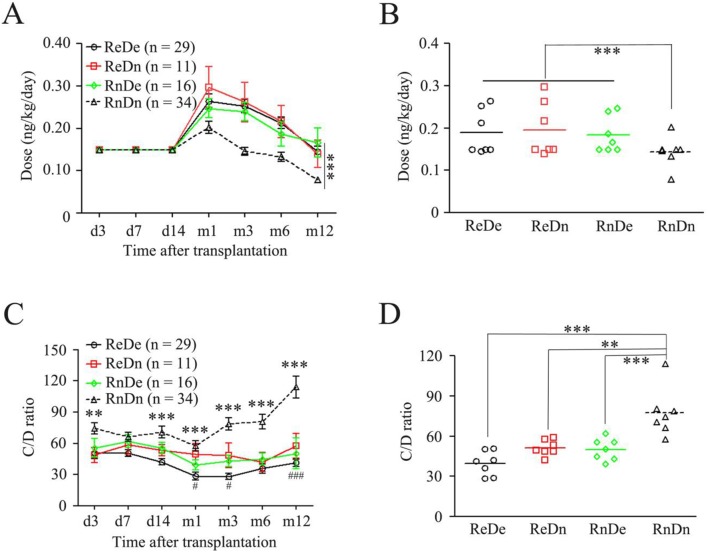
Doses and C/D ratios of TAC compared among four groups: ReDe, ReDn, RnDe and RnDn.(A) Dose-time curves; (B) Doses in dots, every dot represents a dose at a time point; (C) C/D ratio-time curves; * compared with ReDe; # compared with ReDn; (D) C/D ratios in dots, every dot represents a C/D ratio at a time point. TAC, tacrolimus; Expressor, CYP3A5 *1/*1 and *1/*3; Nonexpressor, CYP3A5 *3/*3; ReDe, recipient with expressor/donor with expressor; ReDn, recipient with expressor/donor with nonexpressor; RnDe, recipient with nonexpressor/donor with expressor; RnDn, recipient with nonexpressor/donor with nonexpressor; *p<0.05; **p<0.01; ***p<0.001; #p<0.05, ###p<0.001.